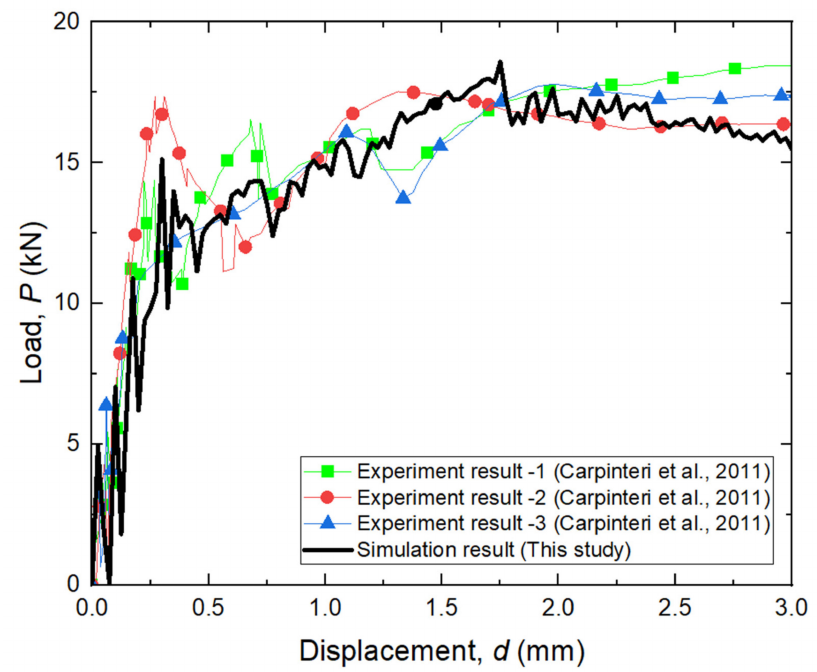
Figure 12. Loading—displacement curves of simulation and experiment in three-point bending testing (This figure has been reproduced from [34] with permission from American Concrete